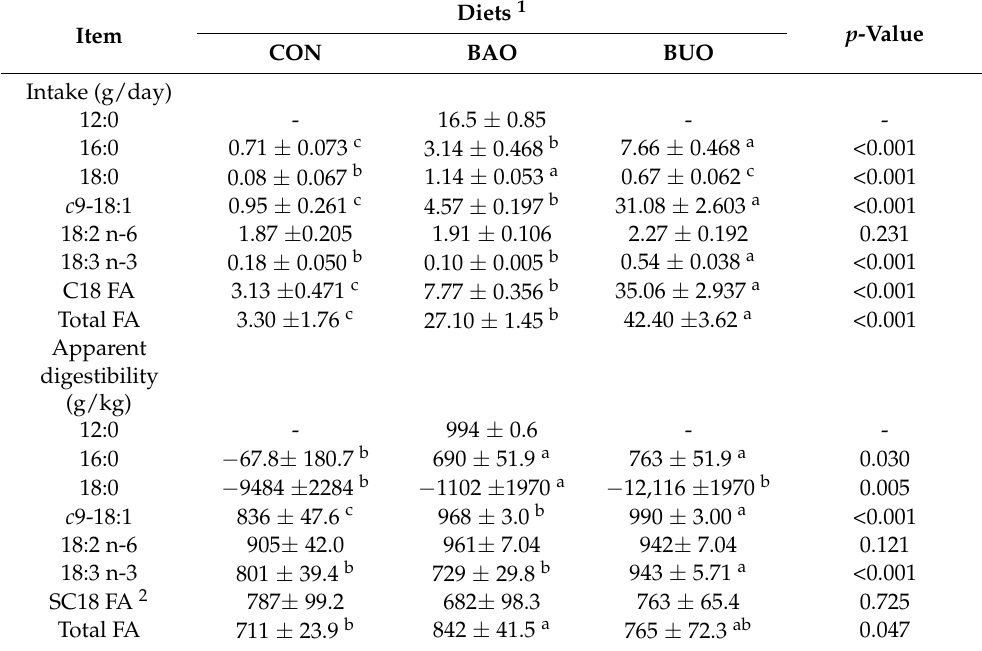
Table 4. Intake and apparent digestibility of fatty acids of sheep fed diets containing babassu or buriti oil.